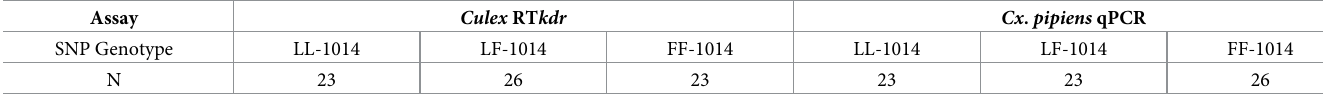
Table 3. Assessing the Culex RT kdr assay using a Cx . pipiens qPCR Taqman assay. Assay